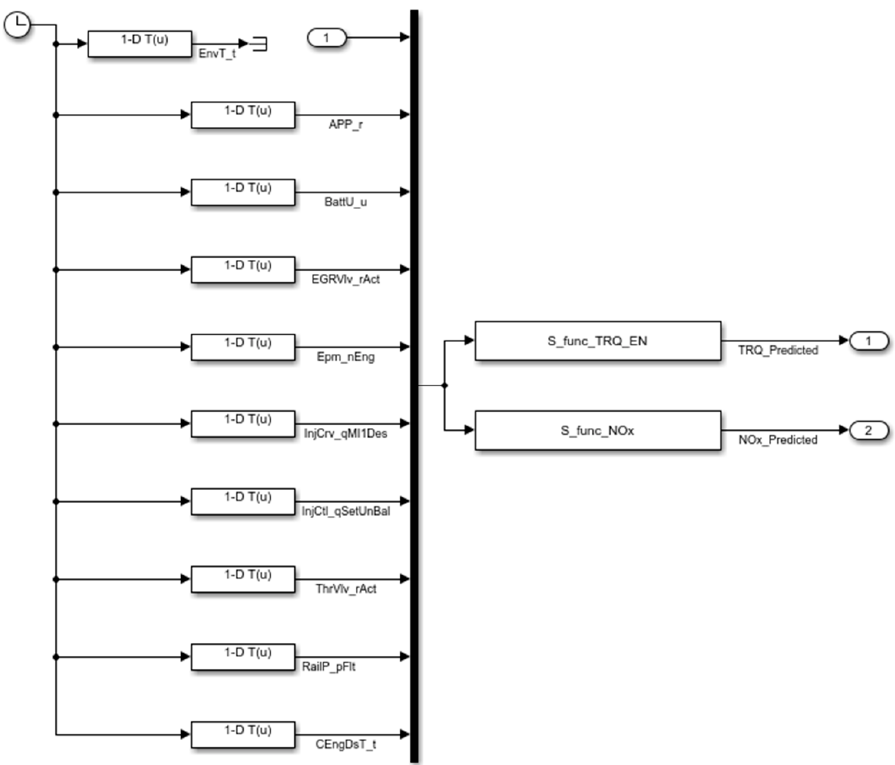
Figure 7. Internal Calculation Logic of Subsystem1~Subsystem3.